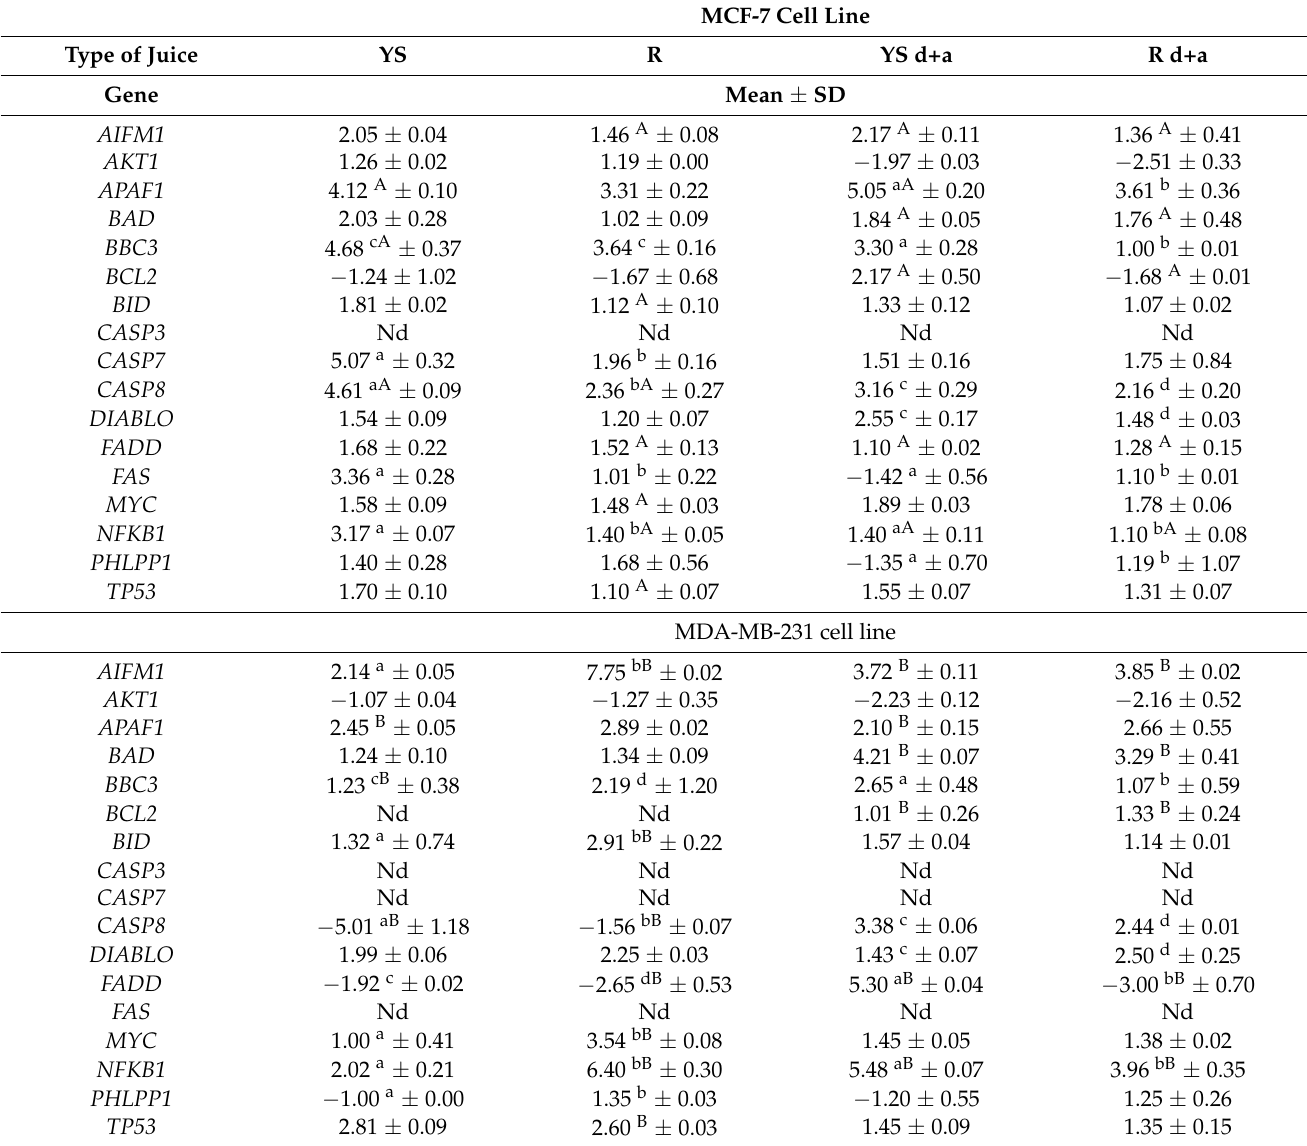
Table 7. Comparison of expression levels of selected genes associated with apoptosis and the cell cycle in cancer cells. MCF-7 Cell